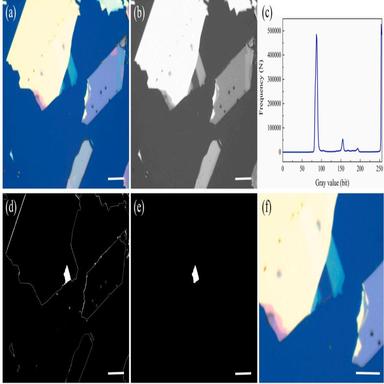
Sample image processing (10 μm in scale). (a) Optical imaging of MoS2 sample. (b) Single channel separation gray image. (c) Gray histogram. (d) Binary image. (e) Morphological open operation processing map. (f) ROI suspicious region labeling.